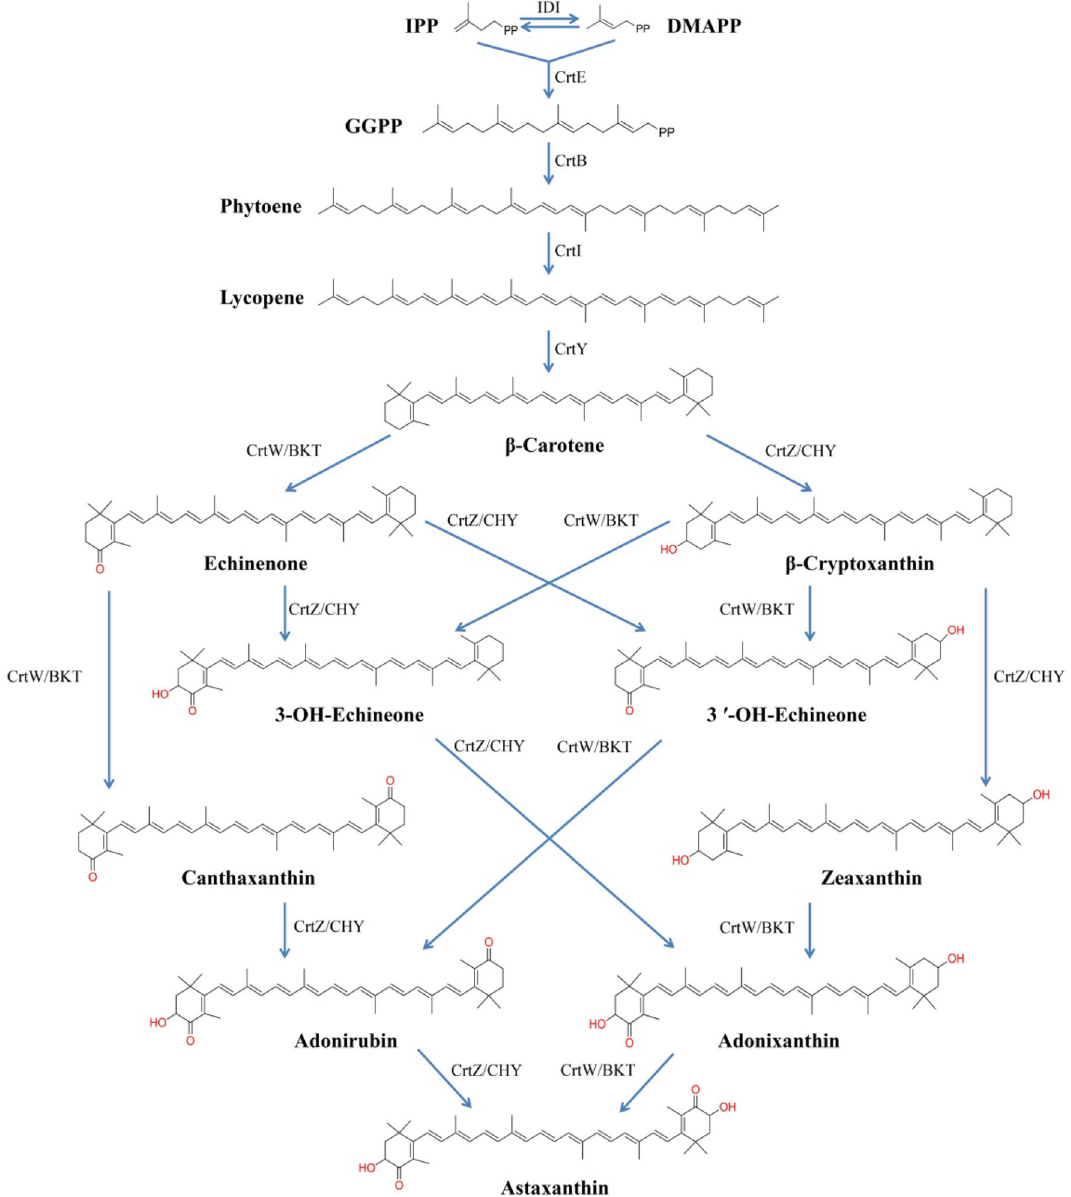
Fig. 1 Biosynthetic pathways of astaxanthin. IPP isopentenyl pyrophosphate, DMAPP dimethylallyl diphosphate, IDI IPP iso- merase, CrtE geranylgeranyl pyrophosphate synthase, CrtB phytoene